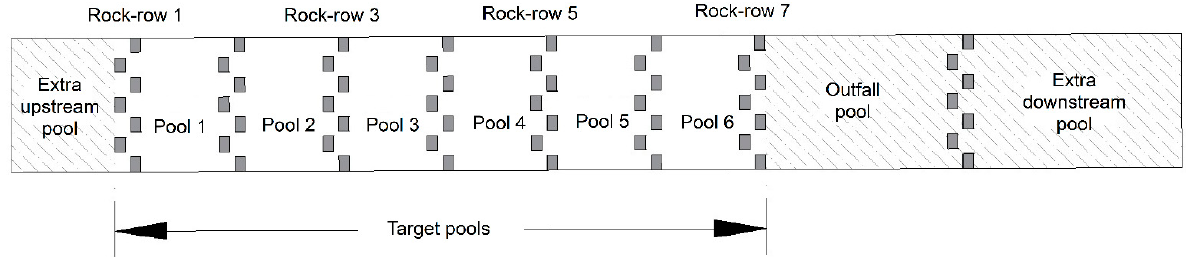
Figure 2. Rectangular boulder layout (R3) for 2D model domain from a top view.